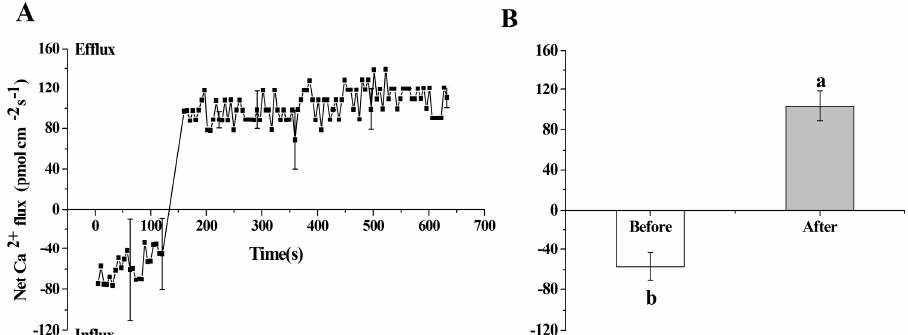
Figure 2. NPPB-induced Ca 2+ flux in tea root on the mature zone cells. ( A ) The kinetics of net Ca 2+ flux in tea root mature zone cells treated with NPPB; ( B ) Net Ca 2+ flux at state of before (0 to 120.76 s, without 50 µM NPPB), and after (160 to 632.5 s, with NPPB). Data indicate mean ± SD ( n = 6). Error bars indicate difference among the treatments and different low case numbers near the chart bars indicate the level of significance as compared with control at p < 0.05.